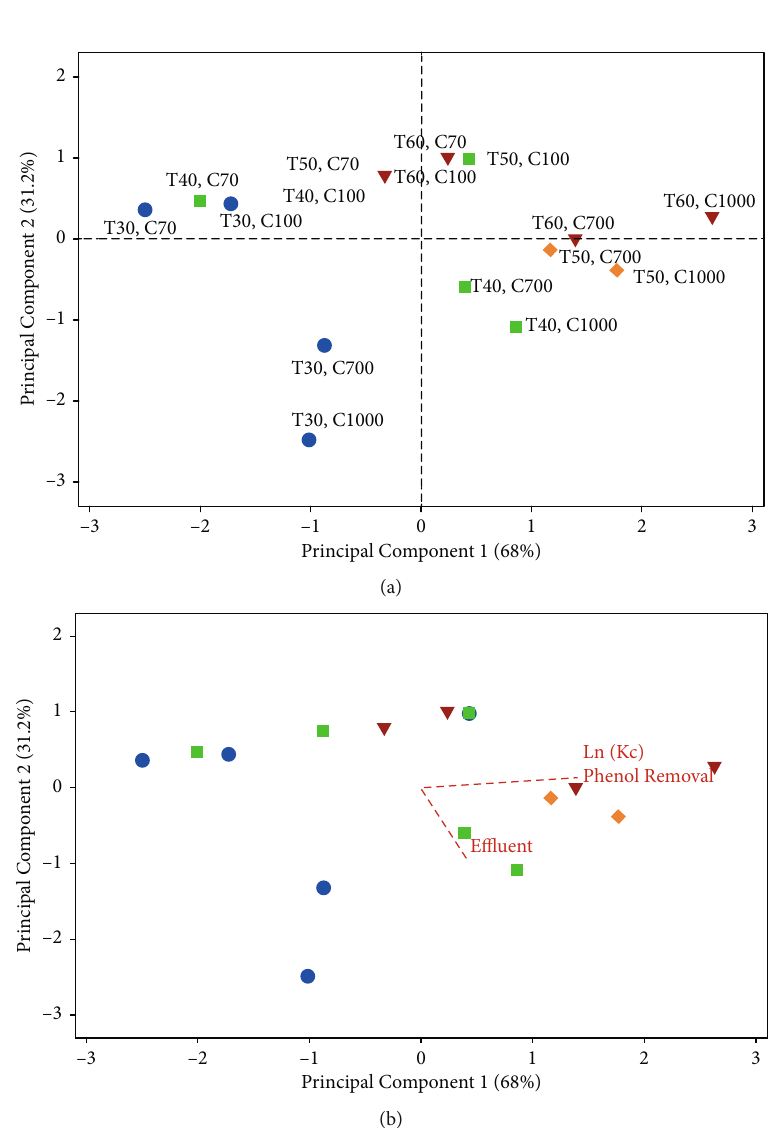
Figure 8: (a) Score plot for PCA analysis of treated samples, PC 1 (68%) and PC 2 (31.2%). (b) Biplot and loading plot of PC1 and PC2 with project lines of all treated samples where sample loadings are represented as vectors radiating from the origin. Sample scores are color coded and indicated by symbols according to each temperature; samples that are similar will plot near to each other (clustered